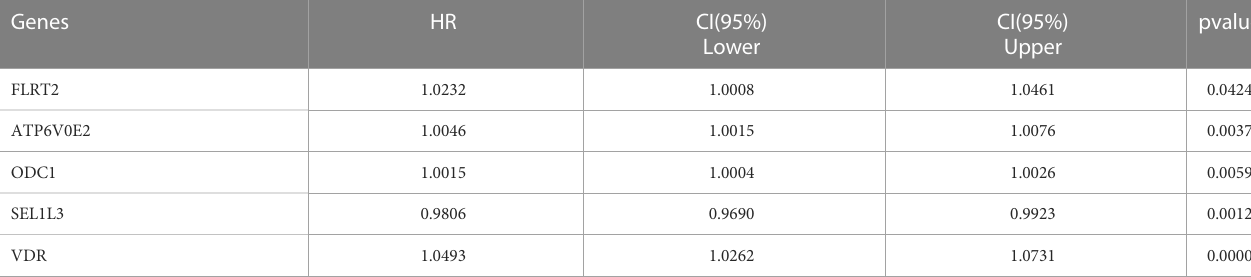
TABLE 2 Five prognostic oxygen-metabolic genes. Genes